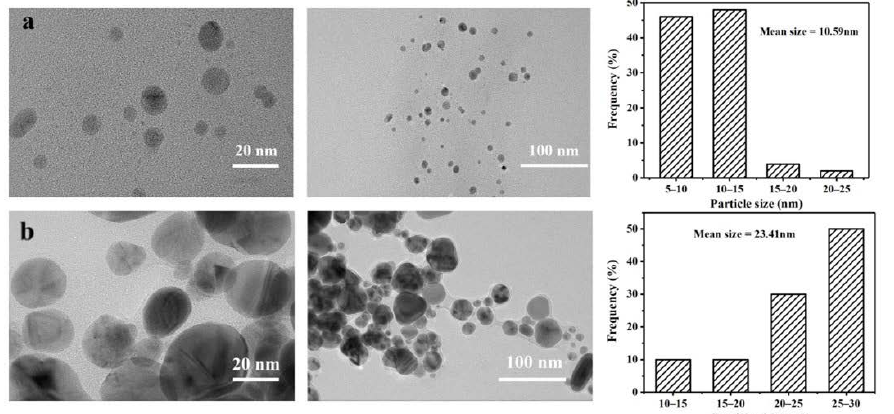
Figure 1. UV-Vis of honeysuckle extract ( a ) and Ag NPs ( b ).